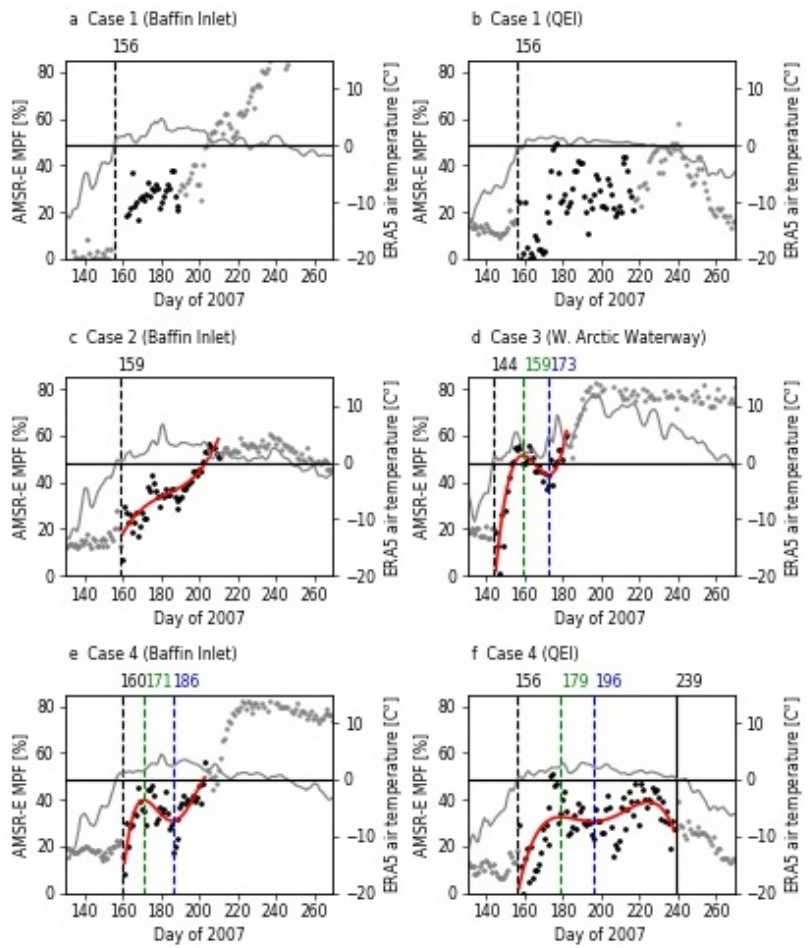
Figure 3. Time series of the Advanced Microwave Scanning Radiometer-Earth observing system (AMSR-E) melt pond fractions (MPFs) and 2 m air temperature from the ERA5 dataset. This figure shows six sets of monitoring points for 2007 in ( a ) Case 1 (Baffin Inlet), ( b ) Case 1 (QEI), ( c ) Case 2 (Baffin Inlet), ( d ) Case 3 (West Arctic Waterway), ( e ) Case 4 (Baffin Inlet), and ( f ) Case 4 (QEI), shown in Figure 2. Black dots are datapoints for estimating drainage onset (DO) and drainage duration (DD). Gray circles and x’s are before melt onset (MO) and include open water contamination under 9/10 sea ice concentration, respectively. Red curves show k-order polynomial regression. Solid gray curves show the 2 m air temperature. Vertical dashed lines show MO (back), DO (green), and DD (blue). Vertical solid black lines show freeze onset. Horizontal solid black lines show 0 ◦ C air temperature.